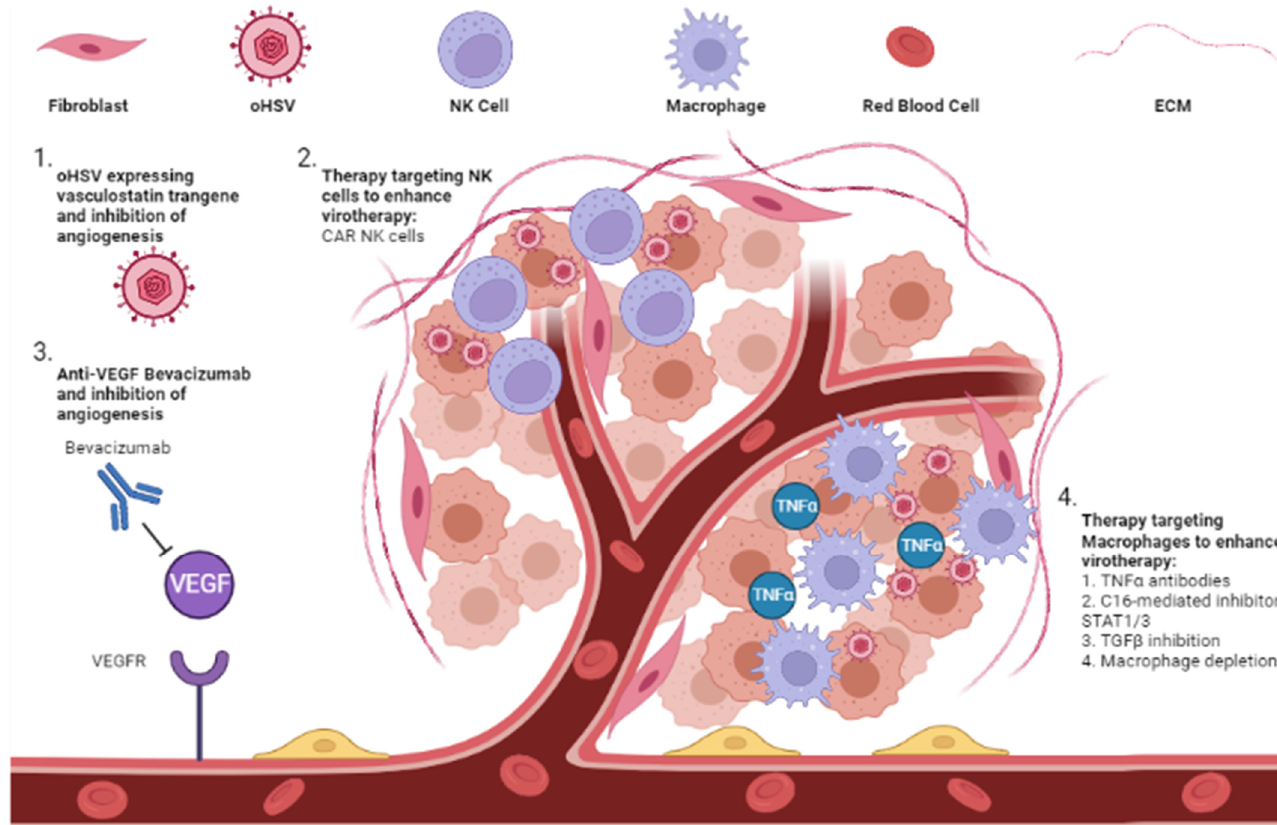
Figure 3. Modulation of tumor ECM to enhance oHSV therapy. Combination of oHSV with modu- lators of the ECM, including anti-angiogenesis therapies and therapies to modulate the anti-tumor response, have shown promising results. (1) oHSV expressing a vasculostatin transgene is able to attenuate tumor angiogenesis and synergistically lead to tumor cell killing. (2) NK cells are part of the ECM and are recruited to oHSV-infected tumor cells. NK cells are activated when tumor cells are infected, which leads to increased killing of infected cells and diminishes viral replication and spread. Exogenous CAR NK cells are a potential therapy to combine with oHSV to enhance viral replication and spread. (3) The anti-VEGF antibody, bevacizumab, leads to inhibition of VEGF binding with the VEGF receptor and leads to decreased angiogenesis and nutrient depletion of tumor cells. This has been combined with oHSV and led to increased tumor cell killing. (4) Macrophages also target oHSV-infected cells and secrete TNF α , leading to an anti-viral response preventing viral replication and spread. Antibodies targeting TNF α and C16-mediated blockade of STAT1/3 phosphorylation leads to increased viral efficacy through increased viral replication and spread. Macrophage depletion and TGF β inhibition are further therapeutic strategies to enhance these effects.